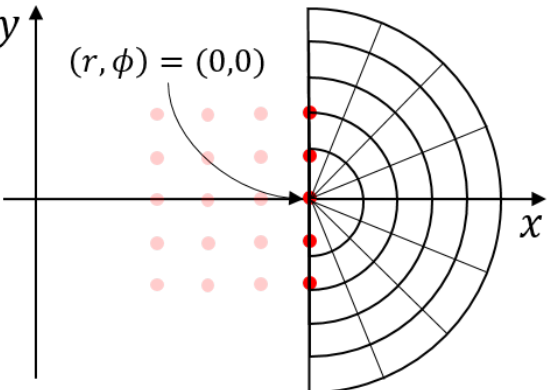
Figure 2. Fixed polar grid where the signal is back-projected. Notice that this grid is strictly polar just for the last acquisition where the origin of the grid is co-located with the center of the virtual